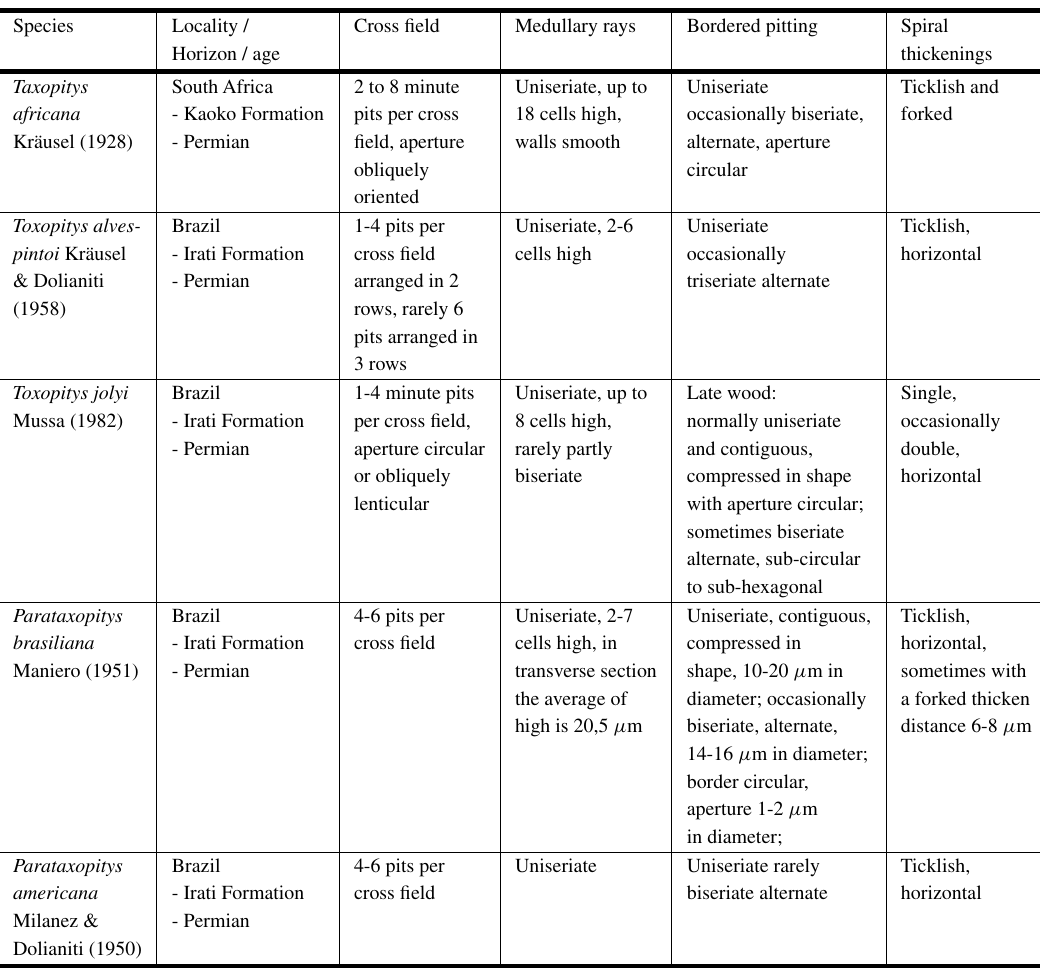
Characterization of fossil woods with spiral thickenings in radial walls of tracheids. Fossil with primary